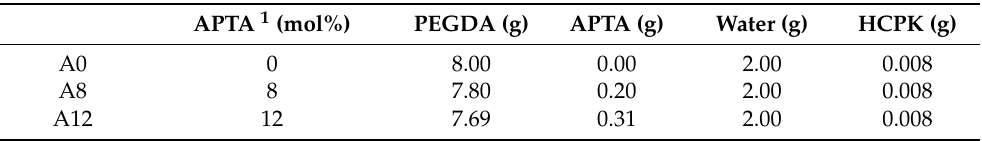
Table 1. Membrane properties of pre-polymerization